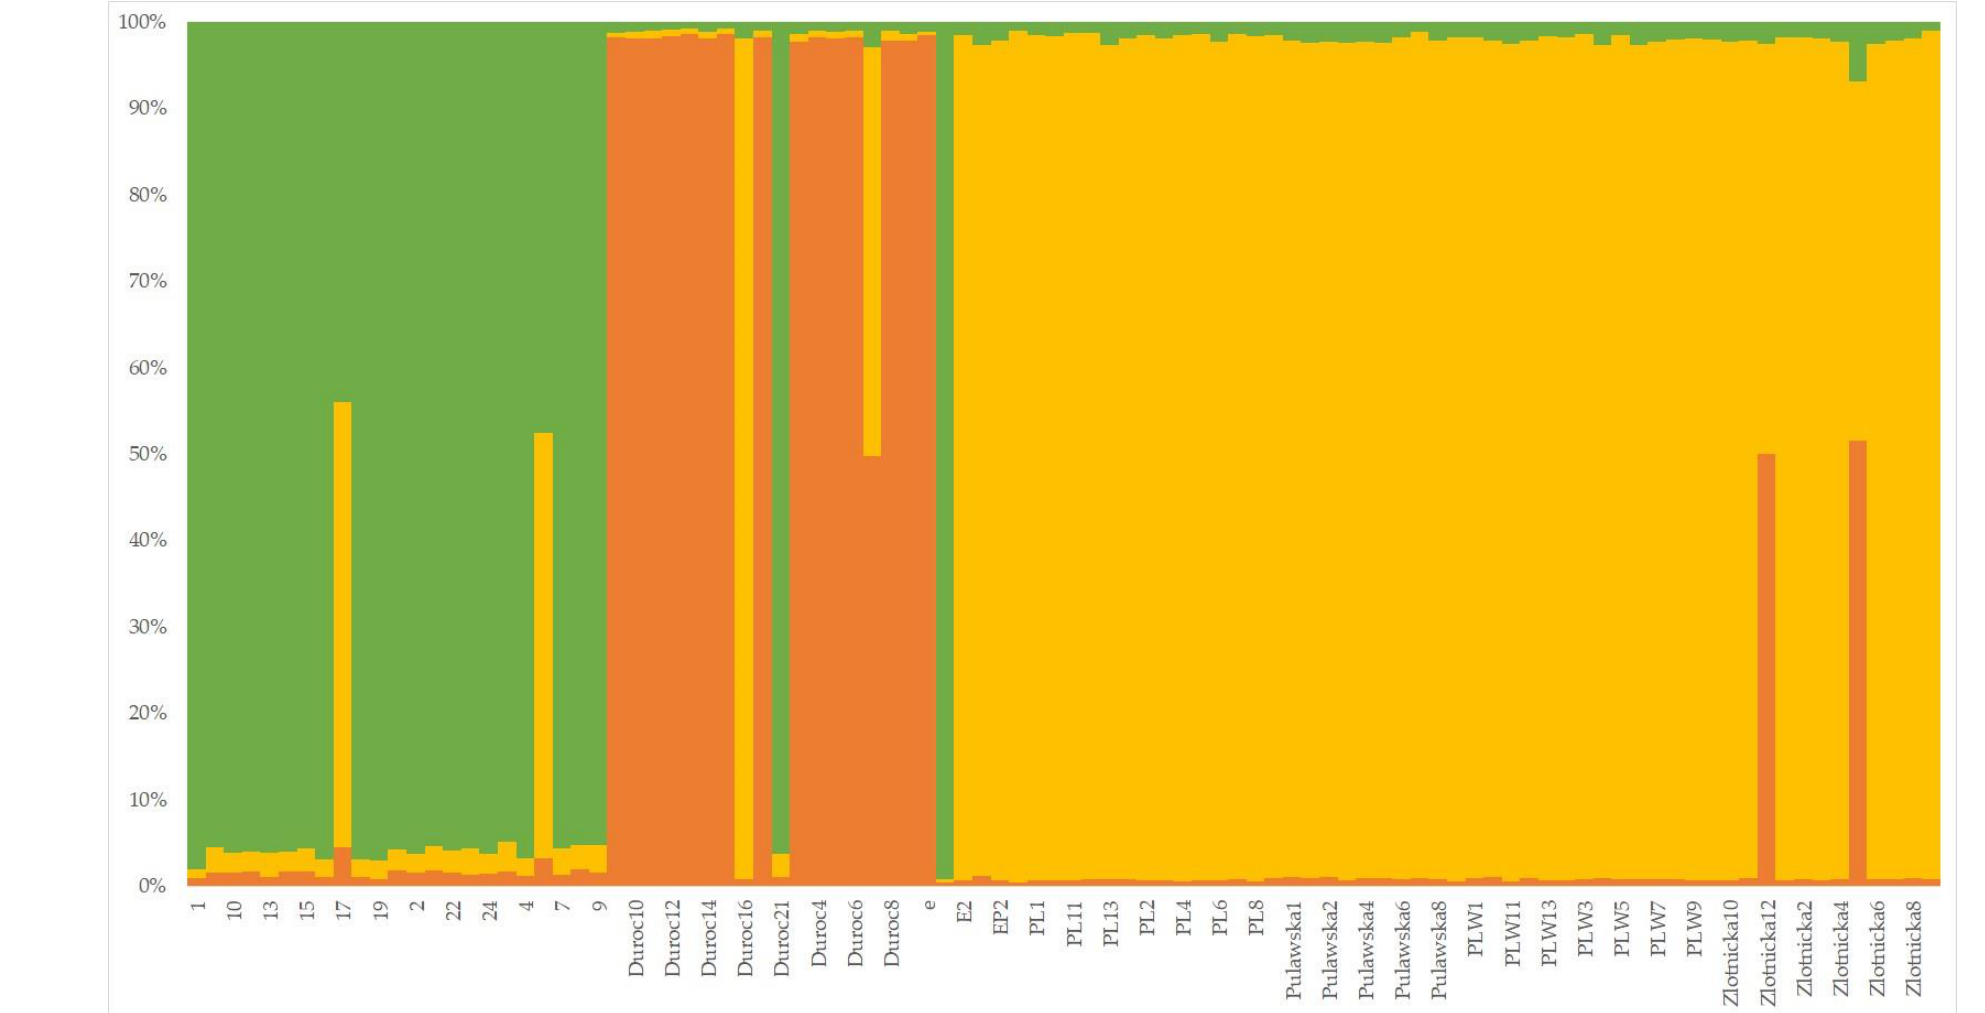
Figure 1. A pattern of MC1R admixed profiles in analysed samples; the computed number of expected population is K = 3; allele sequences are available on GeneBank: E + (AF082490, [6]), E D1 (AF082489, [6]); e (EU443691, [7]), E P2 (EU443722, [7]), E D2 (EU443685, [7]), E P3 (EU443726, [7]).